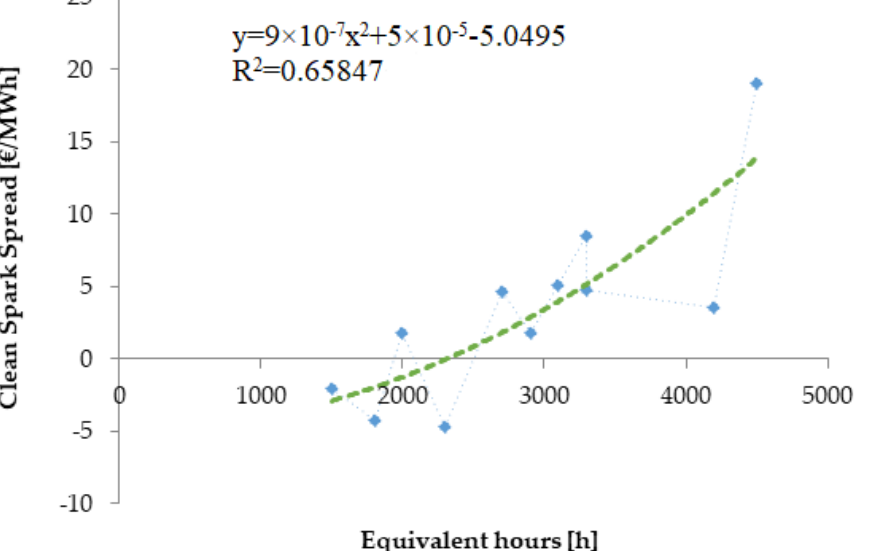
Figure 5. Correlation between clean spark spread (CSS) and annual equivalent working hours for CCGT power plants